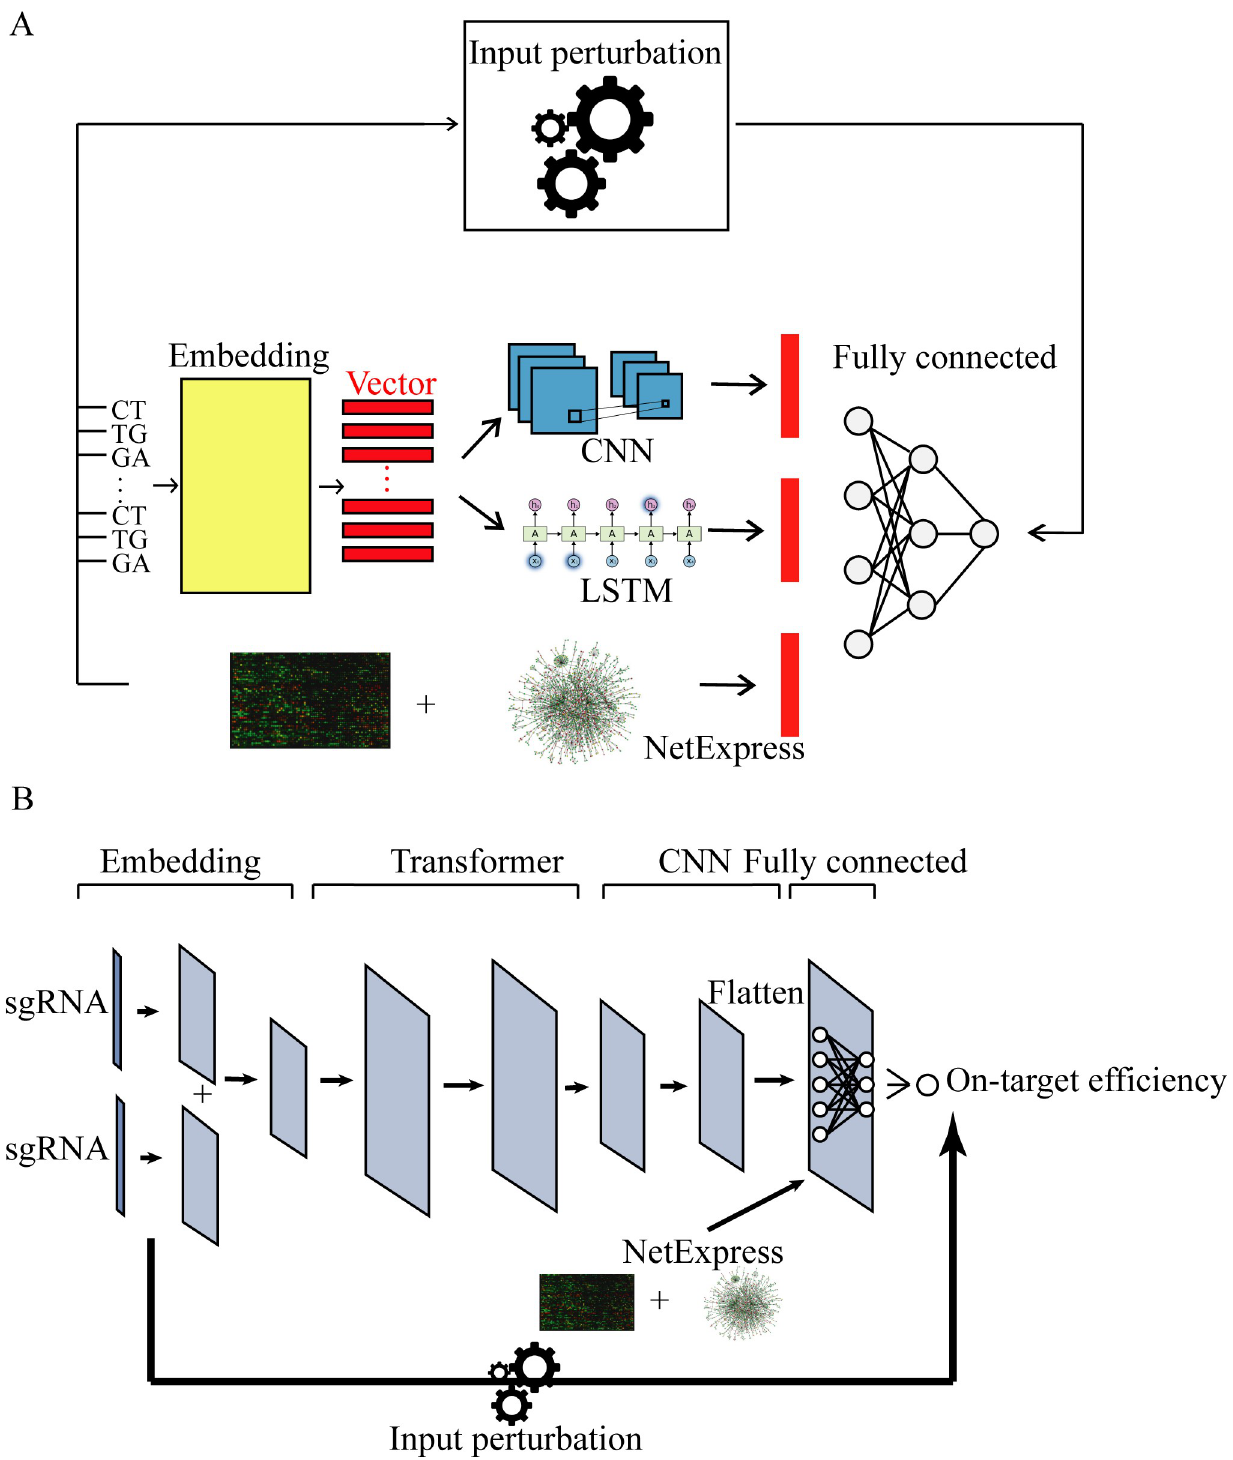
Fig 2. Schematic representation of on target efficiency prediction models, A) SeqCrispr and B) AttnToCrispr_CNN.